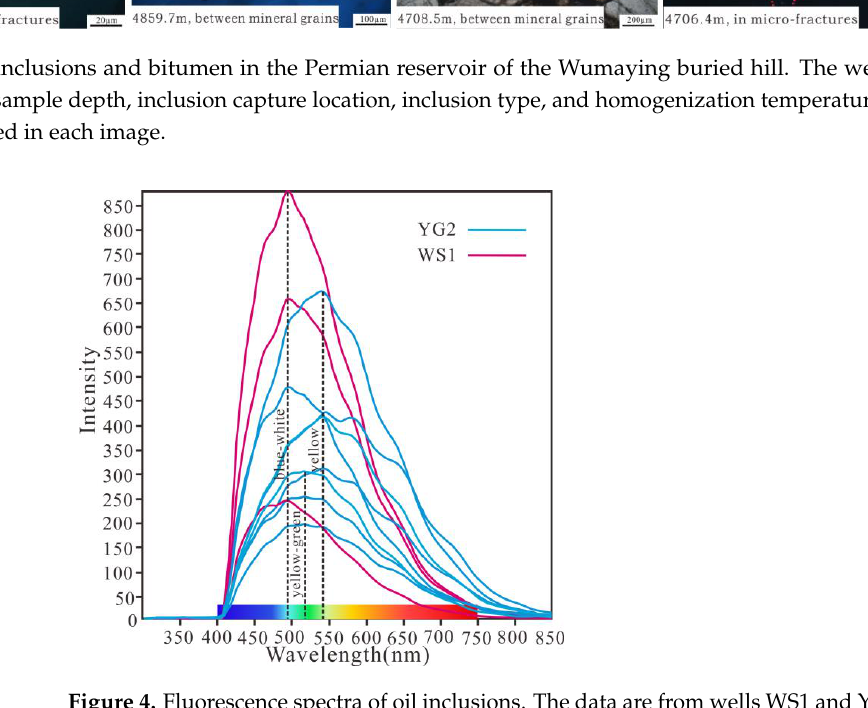
As the Permian has undergone multiple periods of subsidence (Jin et al., 2019), the resulting large burial depth caused an overall strong compaction. Strong compaction resulted in the line contact and concave – convex contact between particles (Figure 5A – D), and even broken particles (Figure 5A,J). Cementation mainly includes the cementation of carbonate (Figure 5E,F,I,P), clay mineral (Figure 5E – H), and siliceous mineral (Figure 5G). Calcite cementation is the most common; two types of calcite existed. The calcite cementation with orange – yellow cathodoluminescence was formed in the early period (Figure 5I), and the calcite with ark blue cathodoluminescence was formed in the late accumulation period (Figure 5P) [21]. In the YG2 well, calcite cementation of the early generation was commonly observed (Figure 5E,F,I); the ferroan calcite was also occa- sionally seen as appearing at the edge of calcite cementation of the early generation (Figure 5M,N). In the WS1 well, ferroan calcite cementation was common, mostly occur- ring at the edge of calcite cementation of the early generation and occupying its space (Figure 5K,O,P). Dissolution could be commonly seen under the microscope, and the most common was feldspar dissolution. Bright blue cathodoluminescence potassium feldspar and its residual particles could be observed, as well as green cathodolumines- cence anorthite residue (Figure 5E). Calcite, kaolinite, and other minerals could be dis- solved and were often recrystallized in the dissolution pores (Figure 5F,N,O). In addition, carbonaceous bitumen could be seen in both intergranular and dissolution pores (Figure 5H,I,P).